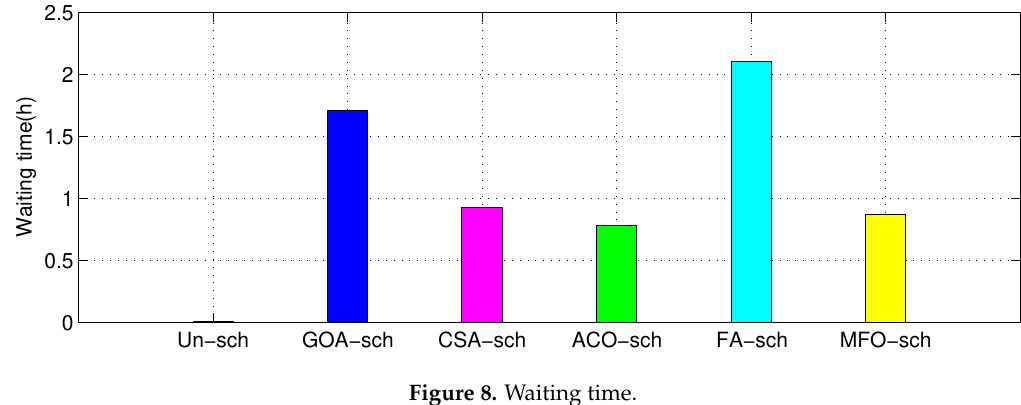
Figure 8. Waiting time.